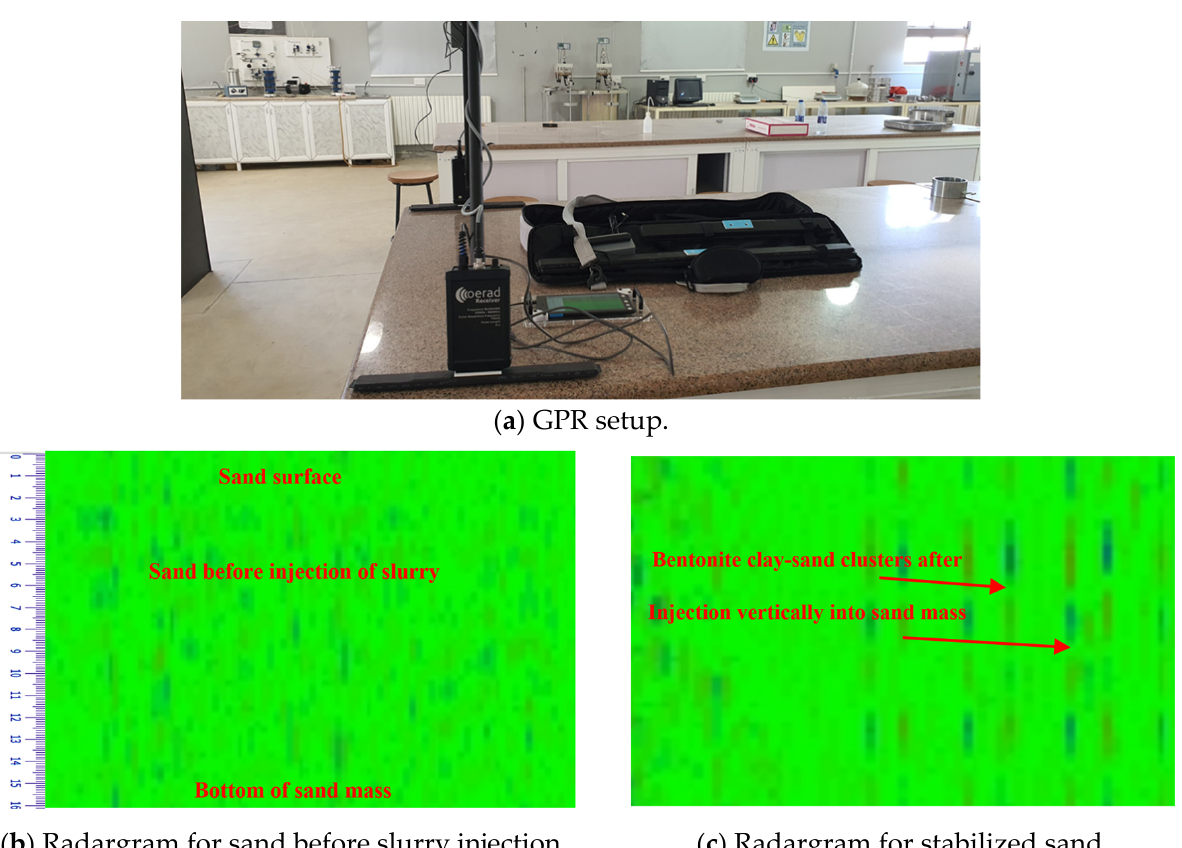
Figure 7. GPR setup and Radargram for non-stabilized and stabilized sand in pilot scale.